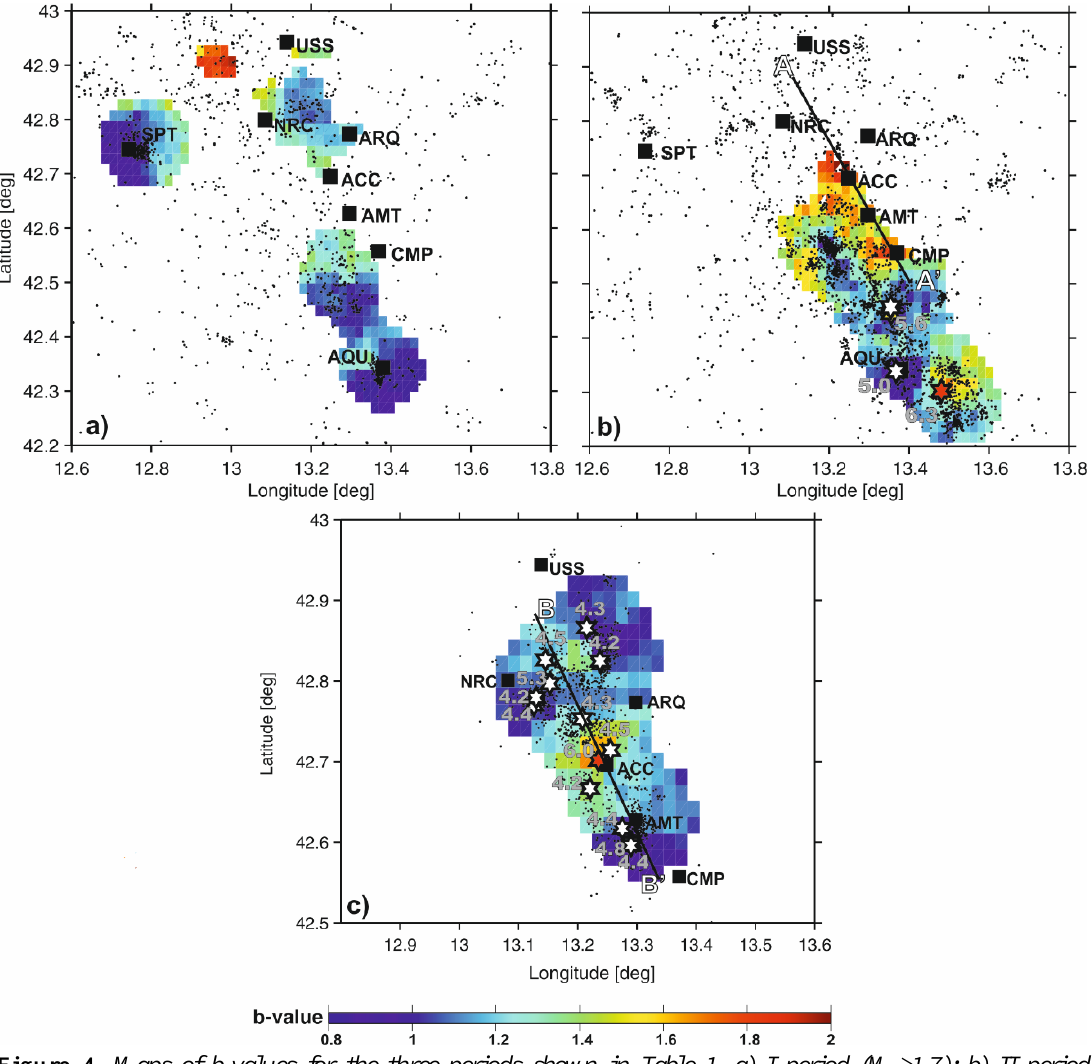
Figure 4 . Maps of b-values for the three periods shown in Table 1. a) I period (M (M  1.9); c) III period (M  2.1). The AA' and BB' lines indicate the b- value cross-sections of Figures 5a c c and 5b, respectively. In Figure 4b the red star is related to the 2009 L'Aquila earthquake, while the white stars indicate the strongest aftershocks of the sequence. Figure 4c shows the 2016 Amatrice aftershocks (white stars) with M  4.2 and the location of the mainshock (M6.0) (red star). Black squares are the main